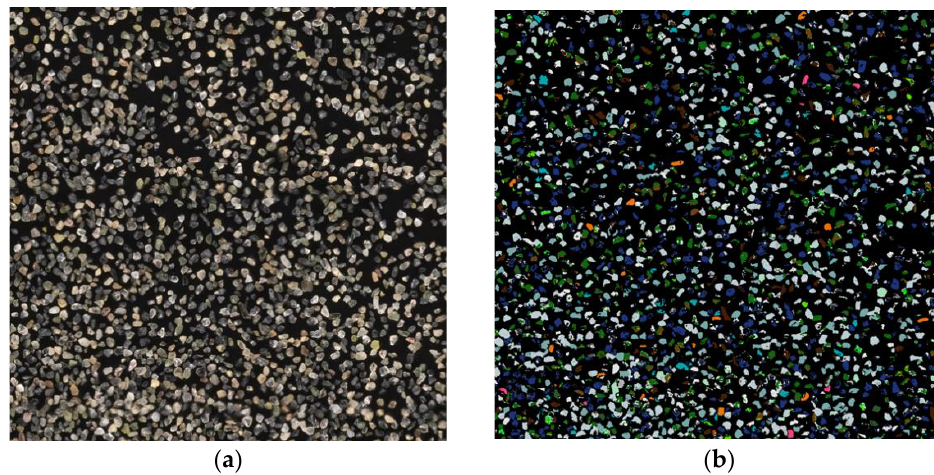
Figure 2. Sample segment of the original ( a ) and SEM-based groundtruth image ( b ).